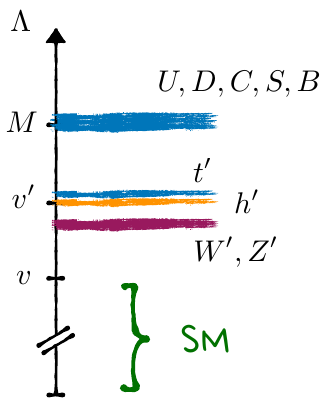
Figure 1 . Schematic illustration of the particle spectrum of parity solutions to the strong CP problem in their least tuned version. The lightest exotic particles are W 0 and Z 0 resonances, followed by a top partner appearing at a scale of order v 0 . A mirror Higgs is also part of the low- √ lying spectrum, with m h 0 ’ 2 λv 0 . (For illustration, we have chosen λ = O (1) , but note that h 0 could be much lighter if λ (cid:28) 1 .) Additional mirror quarks have masses of order the see-saw scale, M (cid:29) v 0 . The lepton sector must also be “see-sawed”, with mirror leptons similarly appearing well above v 0 (although we emphasize that the see-saw scales in the quark and lepton sectors need not